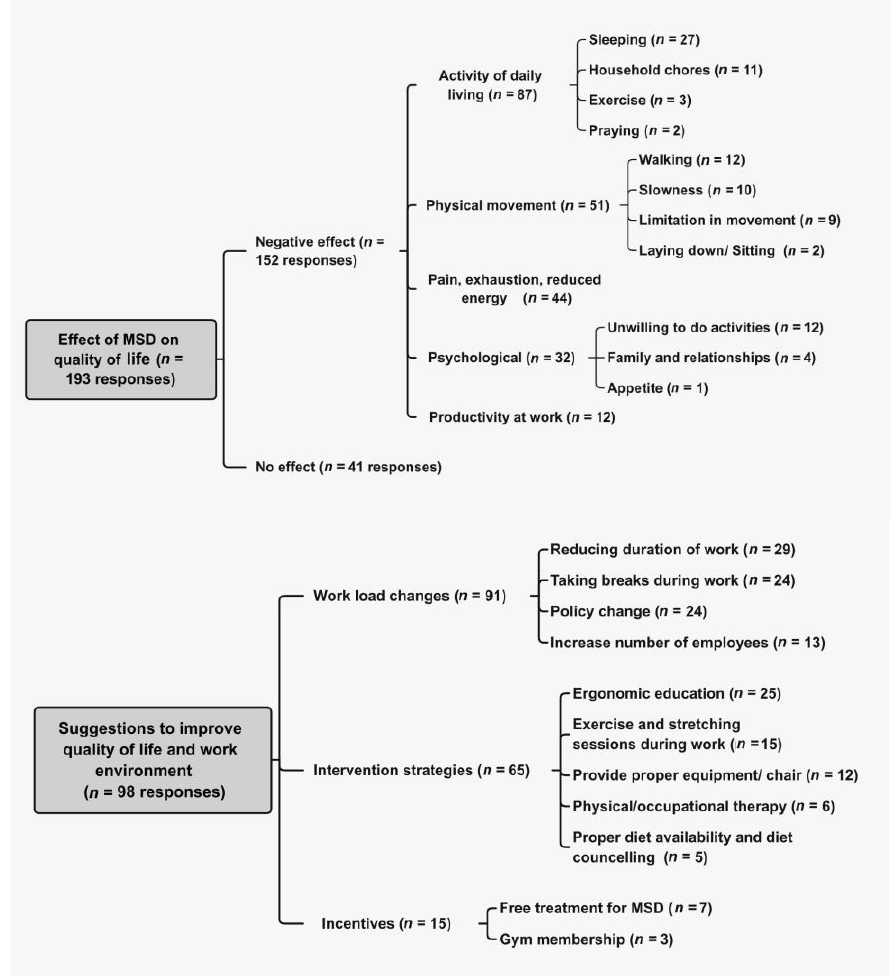
Figure 3. Participants’ responses with emerging themes for the two open-ended questions.